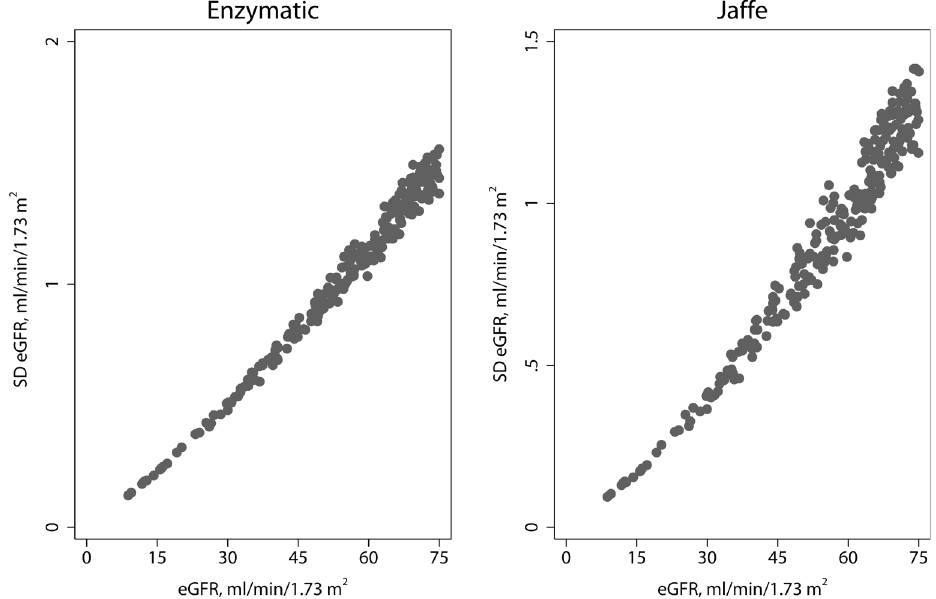
Fig 3. Precision Profile for eGFR Measurements. These Figs show the standard deviation of the eGFR as a function of eGFR for the CKD-EPI method for the enzymatic (left panel) and Jaffe method (right panel). All data (age, sex, and race) are